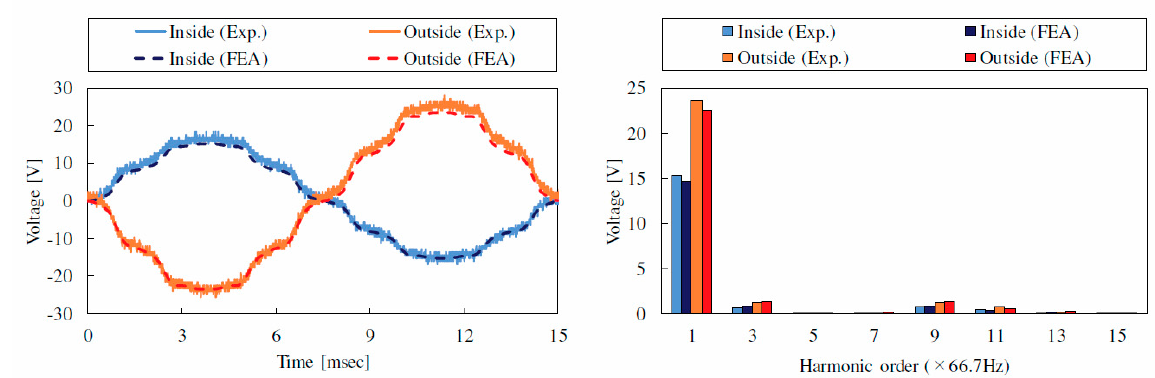
Figure 17. No load back EMF waveforms ( left ) and their FFT results ( right ) at 1000 rpm.